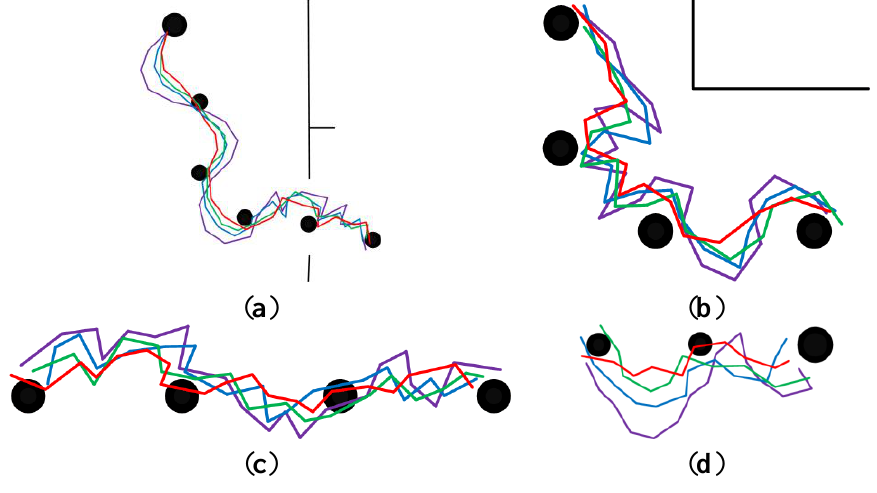
Figure 8. The homing trajectories in non-modified environments with fairly good illumination. ( a – d ) show the results obtained in phase 1, 2, 3 and 4, respectively. Red lines correspond to the proposal. Violet lines correspond to SURF. Blue lines correspond to the proposal without selection and updating. Green lines correspond to the proposal without updating. In each figure, the robot moves from left to right, the black disks with the same size are intermediate nodes, and the bigger one is starting node or home